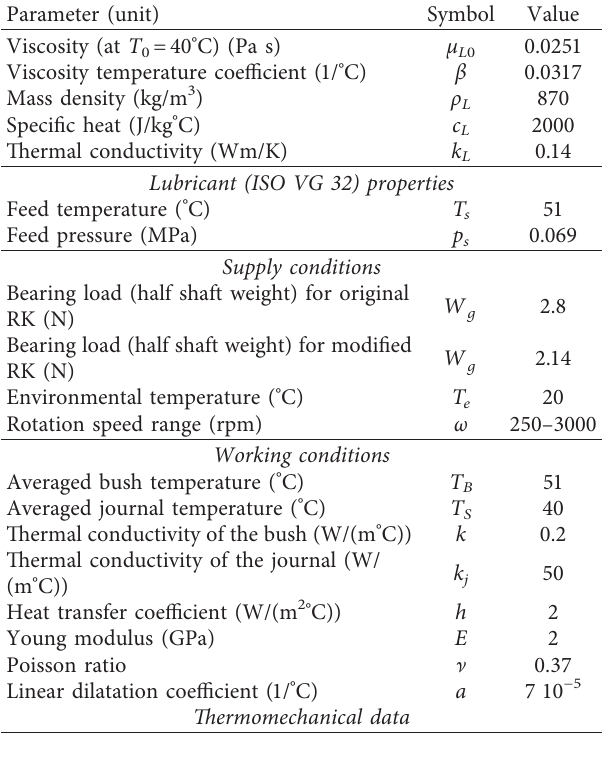
Table 3: Lubrication analysis data.